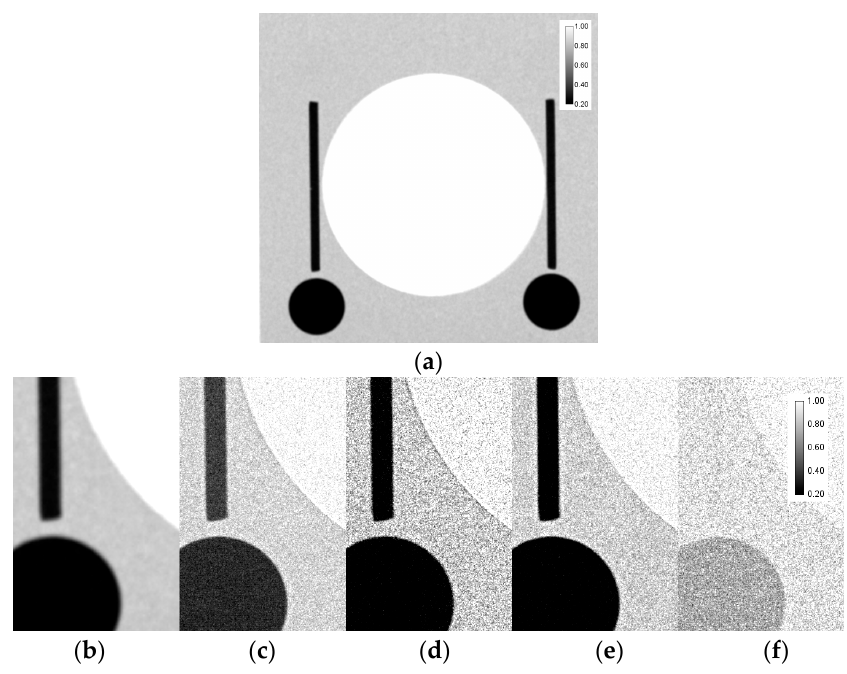
Figure 11. Non-centroided image with original 55 μ m pixel size imaging ASTM beam purity standard with entire spectrum of neutrons, resulting in ~80 μ m resolution ( a , b ). Centroided image with 11 μ m effective pixel size for entire energy range of neutrons summed together ( c ). Centroided image with 11 μ m effective pixel size and with ~40 μ m spatial resolution for each cold ( d ), thermal ( e ), and epithermal ( f ) neutrons. The cadmium wire at the epi-thermal energy is almost completely transparent, signifying a decrease in neutron cross section in the higher energy regime.